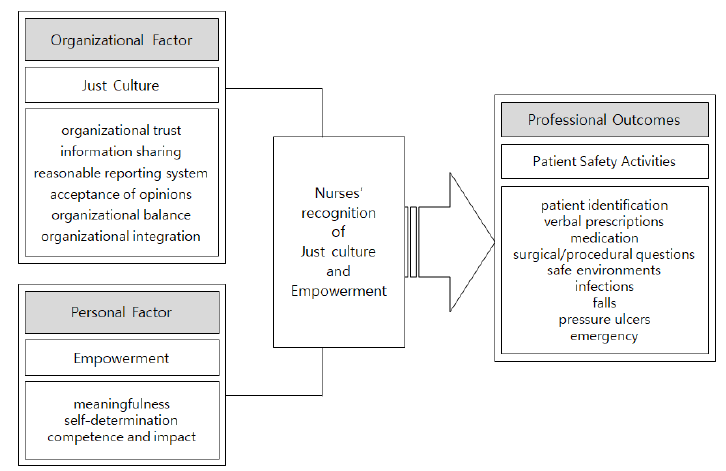
Figure 1 . Conceptual framework of this